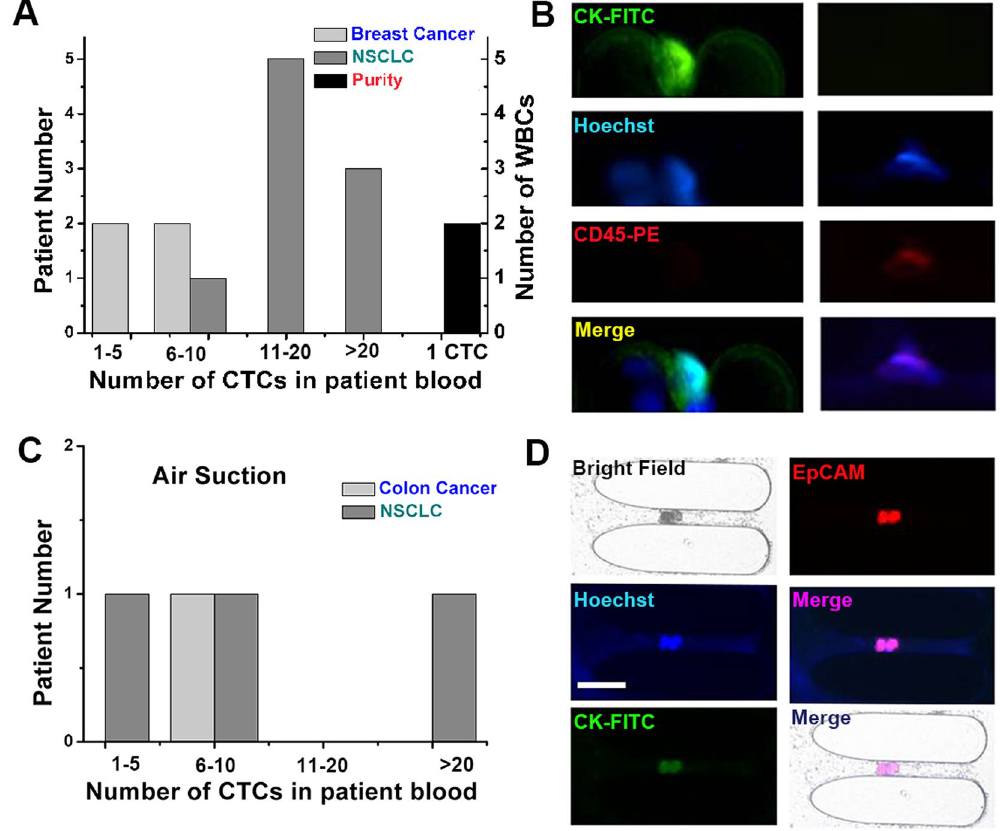
Figure 7. Ellipse filters validation with patient samples. ( A ) Clinical performance of Ellipse filters showing CTCs detected from patients with breast cancer and lung cancer. ( B ) Immunofluorescent staining of a breast CTC recovered showing nucleus, cytokeratin, absence of CD45 and a merged field, and similar staining for leukocytes. ( C ) Clinical performance of Ellipse filters showing CTCs detected from patients with colon